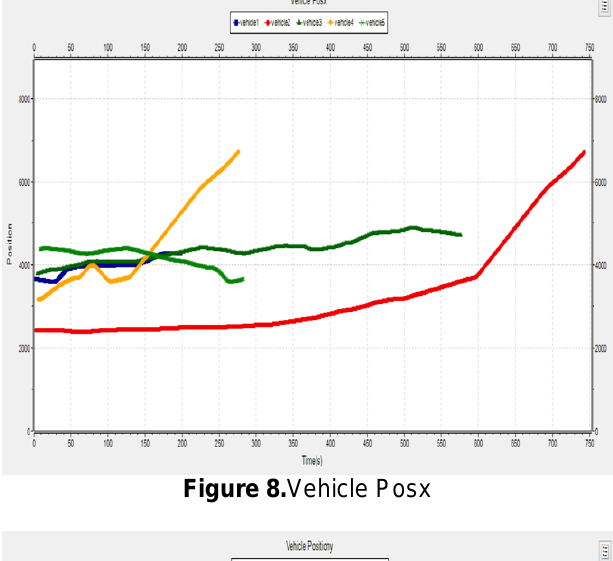
Figure 8. Vehicle Posx